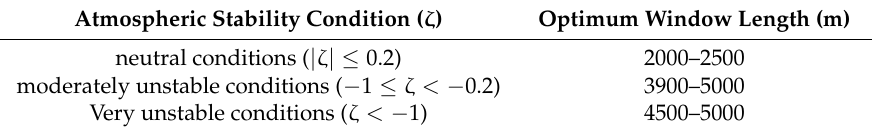
Table 5. The determined optimizing window lengths for turbulent heat fluxes calculation from airborne eddy covariance (EC) method under near neutral to unstable atmospheric stability conditions for the present